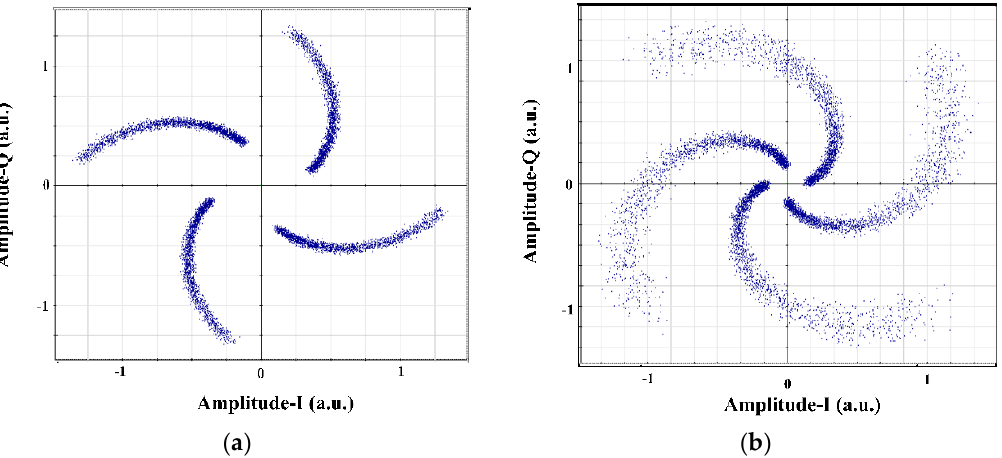
Figure 6. Constellation diagrams of received OFDM at ( a ) 10 Gbps; ( b ) 20 Gbps data rate after 80 km transmission distance.